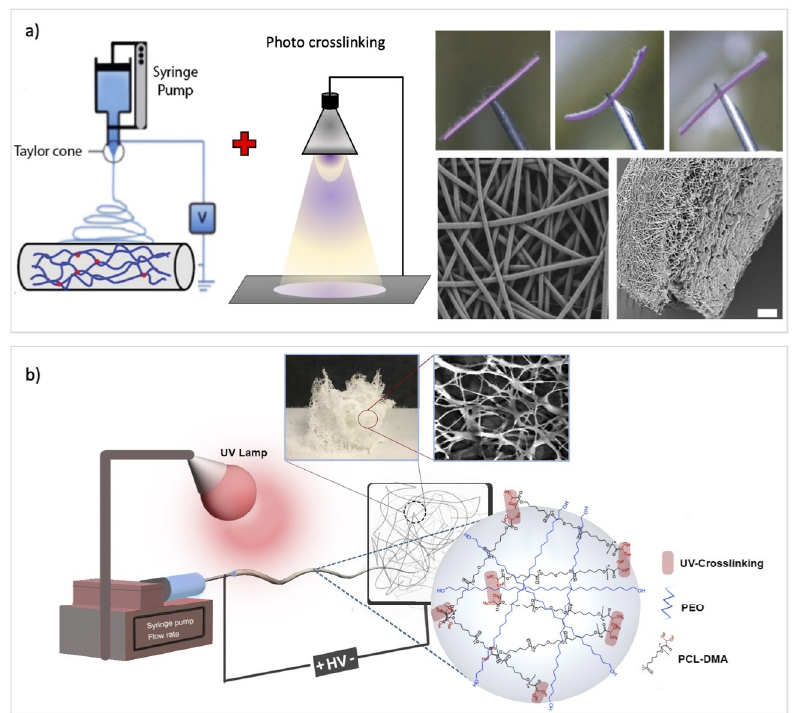
Figure 5. ( a ) Conventional electrospinning method with subsequent UV crosslinking (with per- mission from Wiley, Copyright 2015 [95]); ( b ) electrospinning and simultaneous photocrosslinking (Reprinted with permission from ref. [55]. Copyright 2019